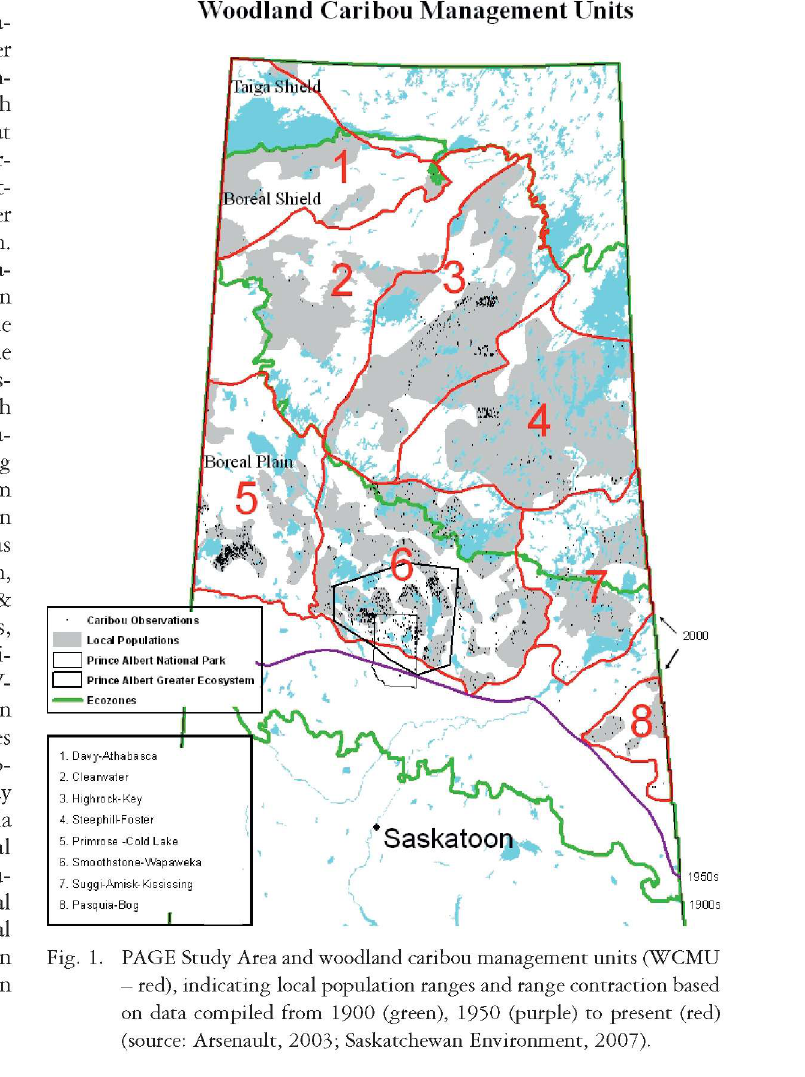
Fig. 1. PAGE Study Area and woodland caribou management units